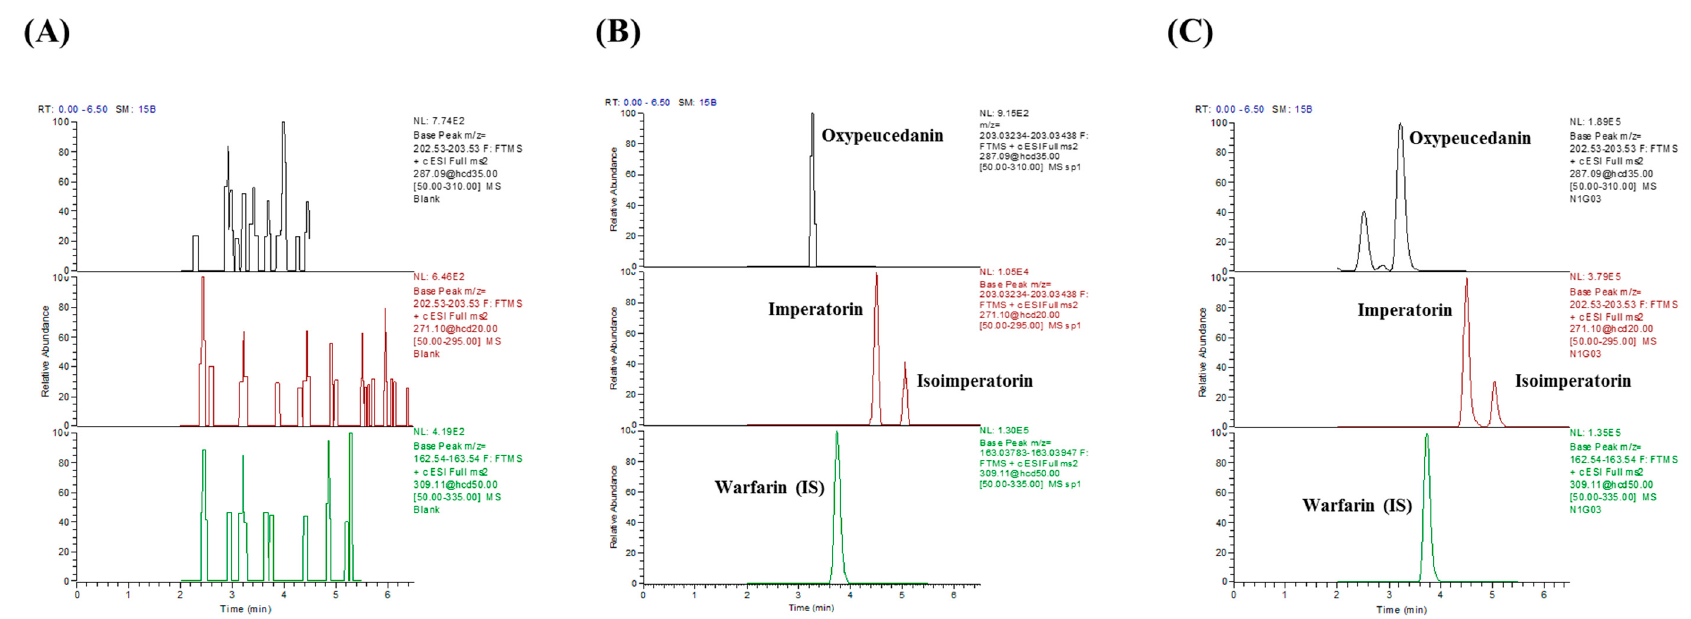
Figure 1. PRM chromatogram of the analytes and internal standard (IS) in plasma: ( A ) blank plasma; ( B ) spiked blank plasma in LLOQ; ( C ) plasma sample after oral administration of Angelica dahurica Radix.